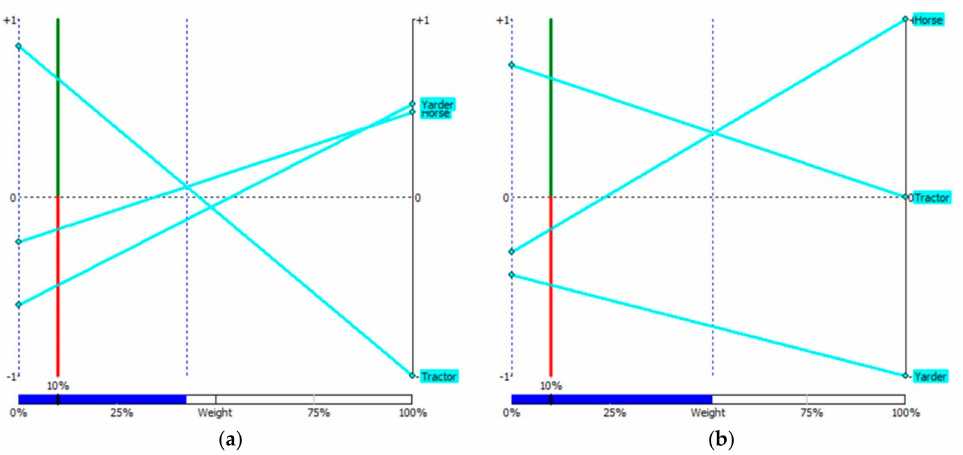
Figure 7. Results of sensitivity analysis using PROMETHEE method when changing weight of #8 EMP (0–0.427) ( a ) and #11 QBS-ar (0–0.511) ( b